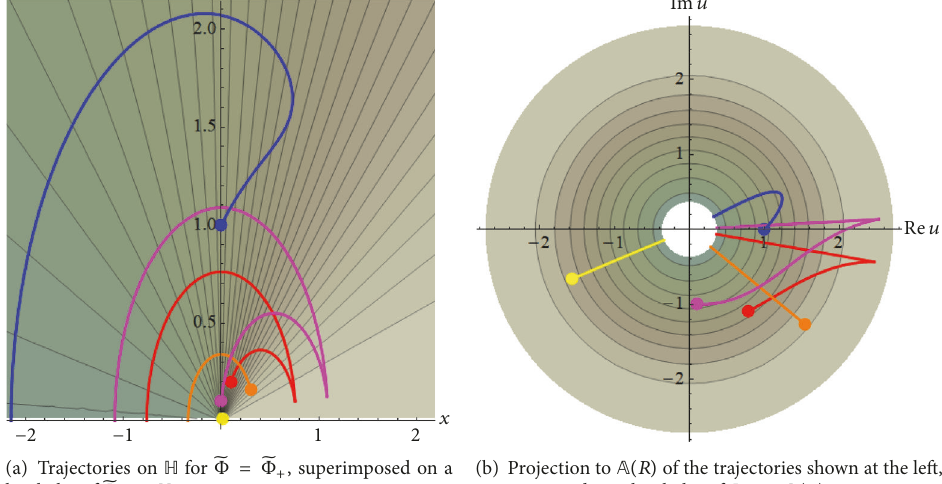
Figure 20: Five trajectories for Φ = Φ + , 𝛼 = 𝑀 0 /3 , and ℓ = 𝜋 2 , with initial conditions of Table